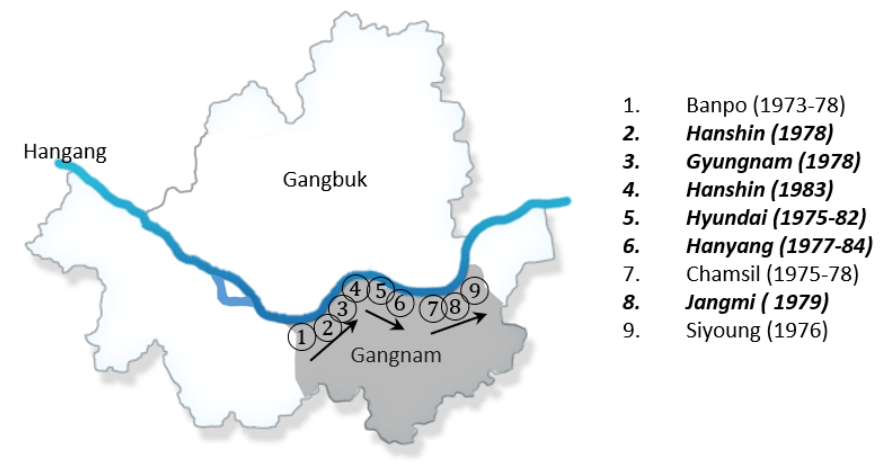
Figure 1. The Gangnam developments of apartments in the 1970s. Adapted from Gelézeau